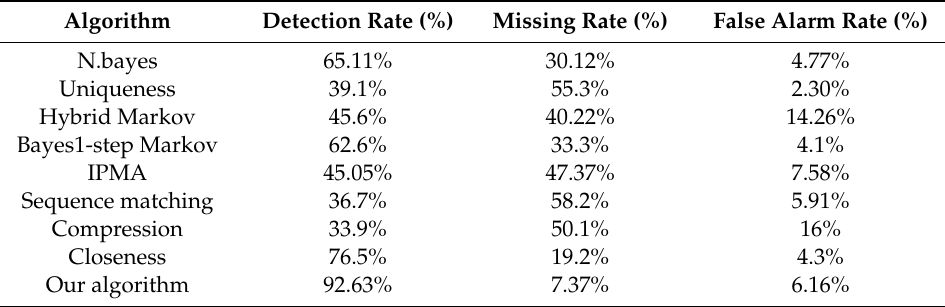
Table 5. Comparison between di ff erent algorithms on